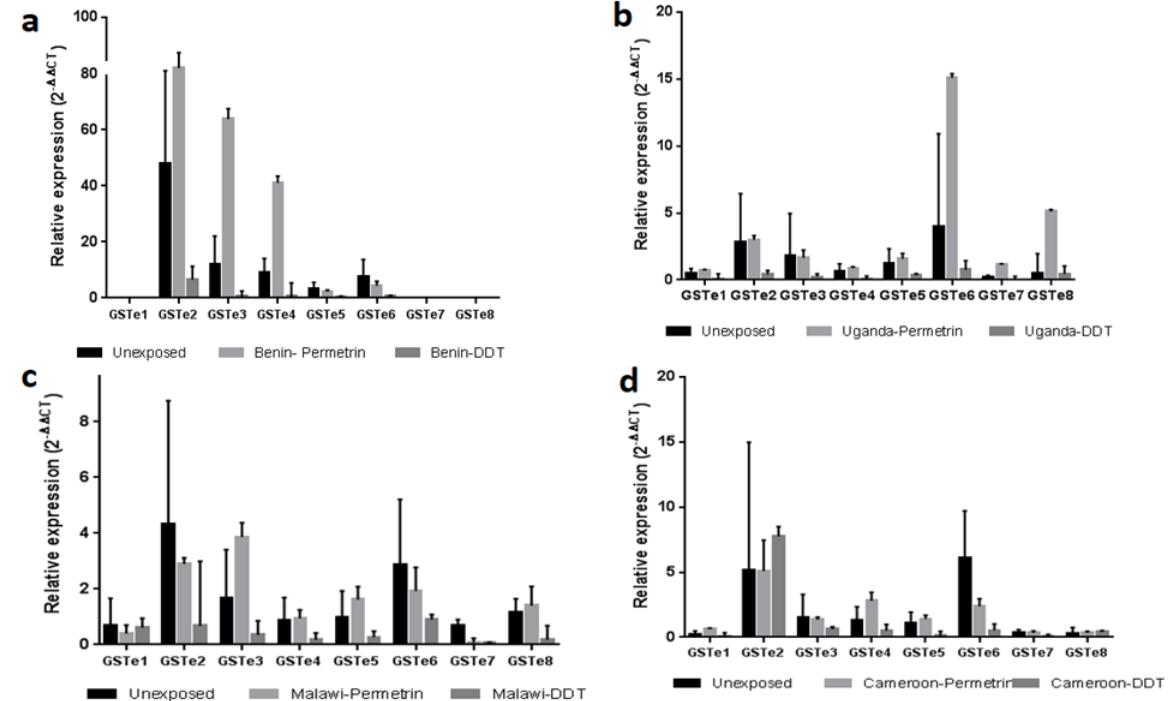
Figure 2. Evaluation of GSTe expression profile across Africa by qPCR. ( a ) GSTe expression profiles in Benin: GSTe2 , 3 and 4 are the more expressed ( b ) GSTe s expression profile in Uganda: GSTe6 , 8 , 2 and 3 are the more expressed; ( c ) GSTe s expression profile in Malawi: GSTe2 , 3 , 6 , 5 and 8 are the more expressed; ( d ) GSTe s expression profile in Cameroon: GSTe2 6 , 4 , 3 and GSTe5 are the more expressed. Consistent with RNA-seq data, GST epsilons are differentially expressed, and expression level is higher in DDT-resistant mosquitoes than the control in